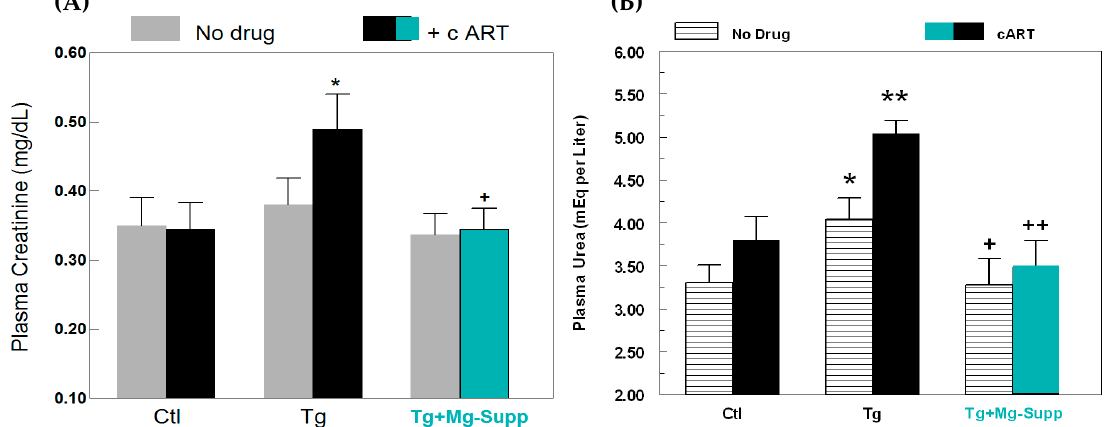
Figure 9. Effects of cART ± Mg—supplementation on ( A ) plasma creatinine levels, and ( B ) plasma urea levels in 18 week Ctl and HIV-1 Tg rats. Values are means ± SE = 5 rats/group. * p < 0.05, ** p < 0.01 vs. Ctl; + p < 0.05, ++ p < 0.01 vs. untreated Tg rats with normal Mg.